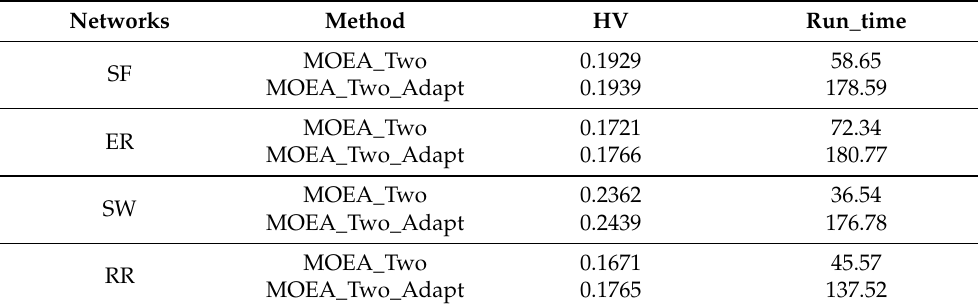
Table 6. Running time (hours) and HV values for MOEA_Two_Adapt and MOEA_Two for four types of complex